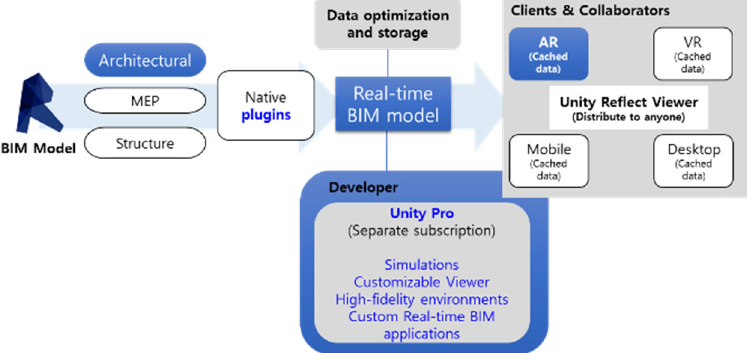
Figure 5. Process of AR-based design checklist connection.